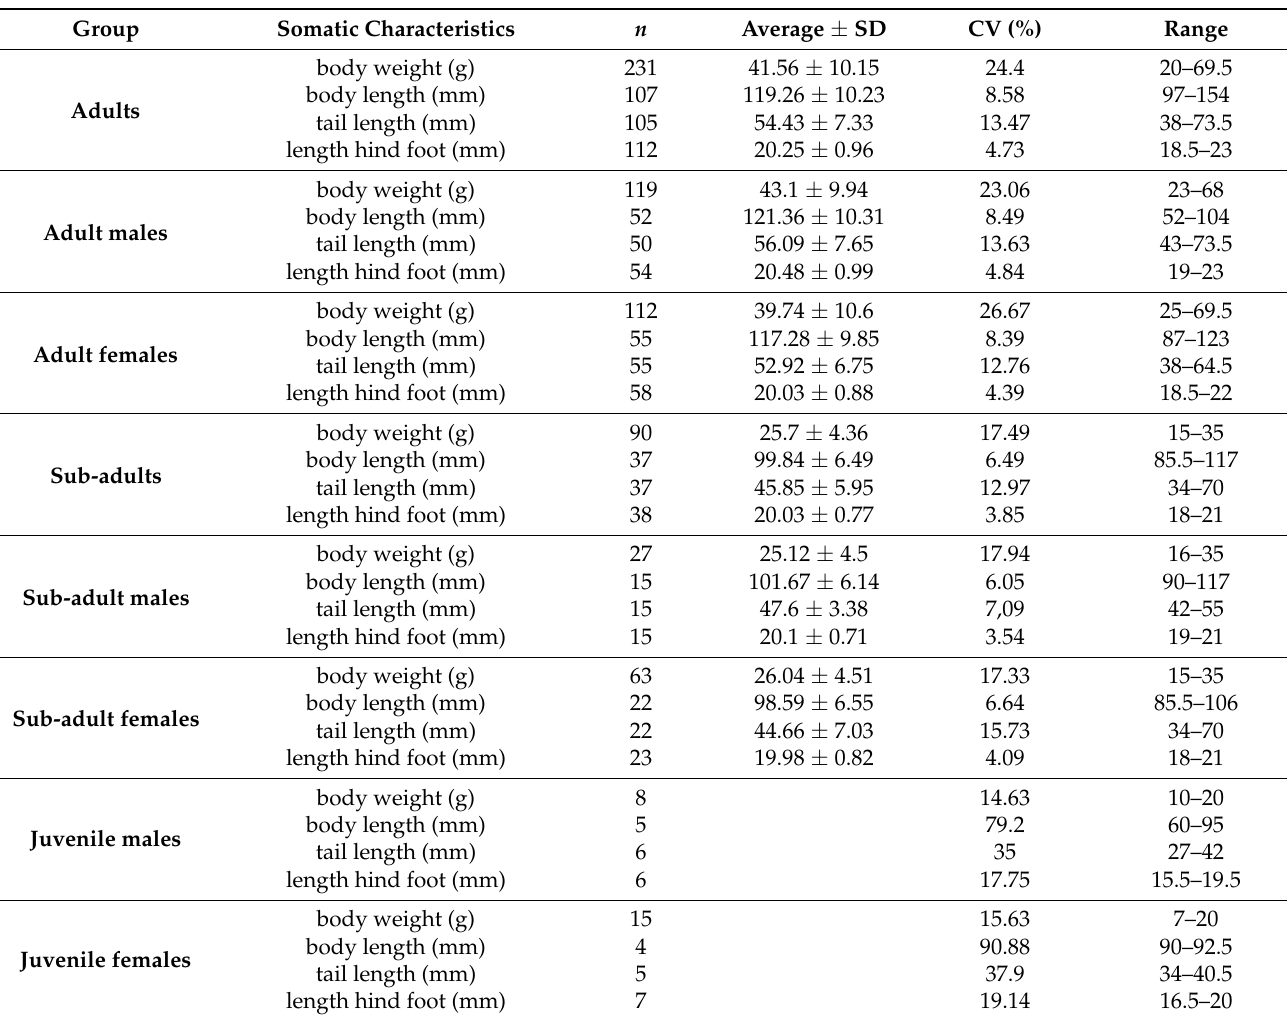
Table 2. Somatic characteristics of Pannonian root